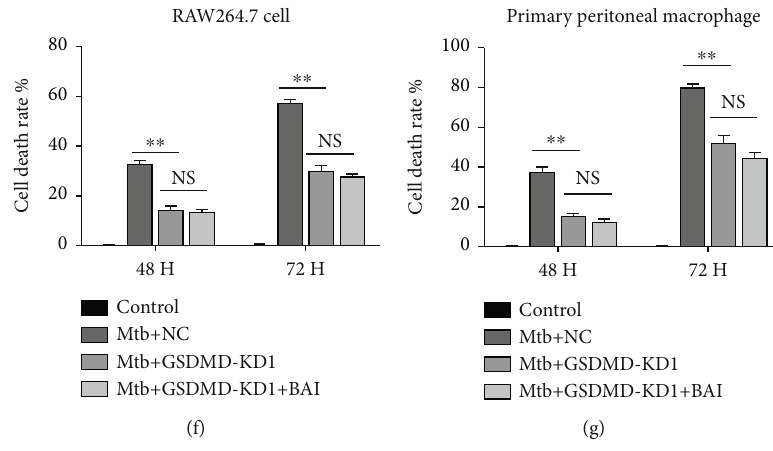
Figure 1: Baicalin ameliorates pyroptosis in Mtb-infected macrophages. (a) Levels of GSDMD-N protein were determined by western blotting in RAW264.7 cells. (b) Levels of GSDMD-N proteins were analyzed by western blot measurement in primary peritoneal macrophage cells. (c, d) Cell death was evaluated applying the Lactate Dehydrogenase (LDH) Cytotoxicity Assay Kit in RAW264.7 cells and in primary peritoneal macrophage cells. (e) Transfection e ffi ciency of siRNAs was measured by western blotting analysis in RAW264.7 cells. (f, g) Cell death after GSDMD siRNA was evaluated applying the Lactate Dehydrogenase (LDH) Cytotoxicity Assay Kit in RAW264.7 cells and in primary peritoneal macrophage cells. Data are shown as mean ± SD of three independent experiments. ∗ p < 0 : 05 ; ∗∗∗ p < 0 : 001 ; NS: nonsigni fi